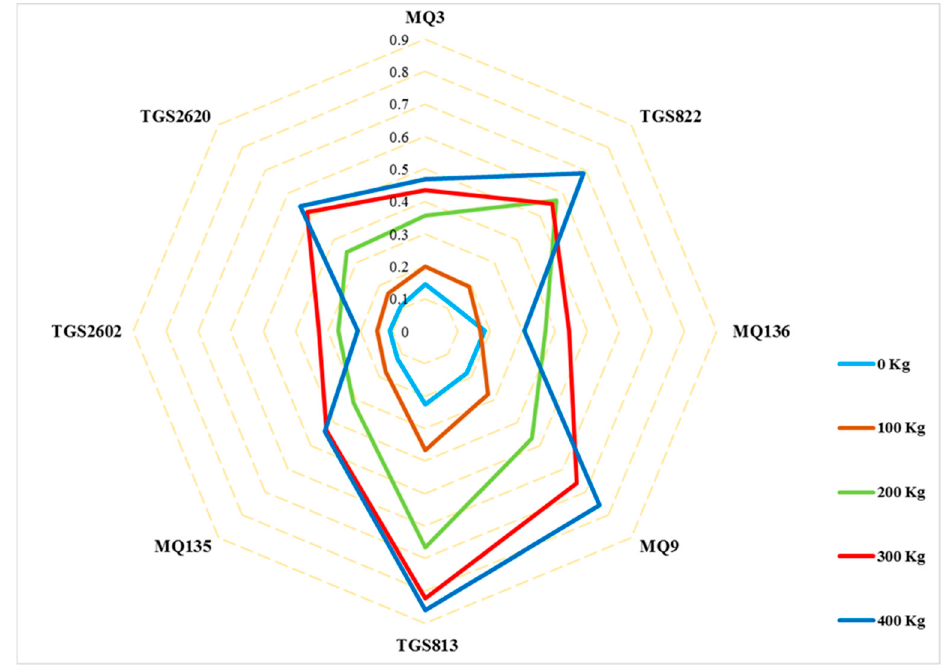
Figure 3. Radar graph response of sensors in the e-nose sensor array.